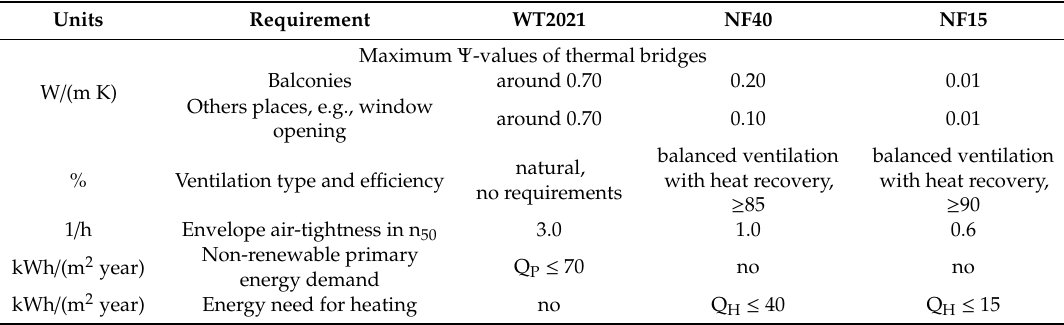
Table 4. A list of linear heat loss coefficients ( Ψ -value) and system requirements for the WT2021, NF40 and NF15 standards [3,19].